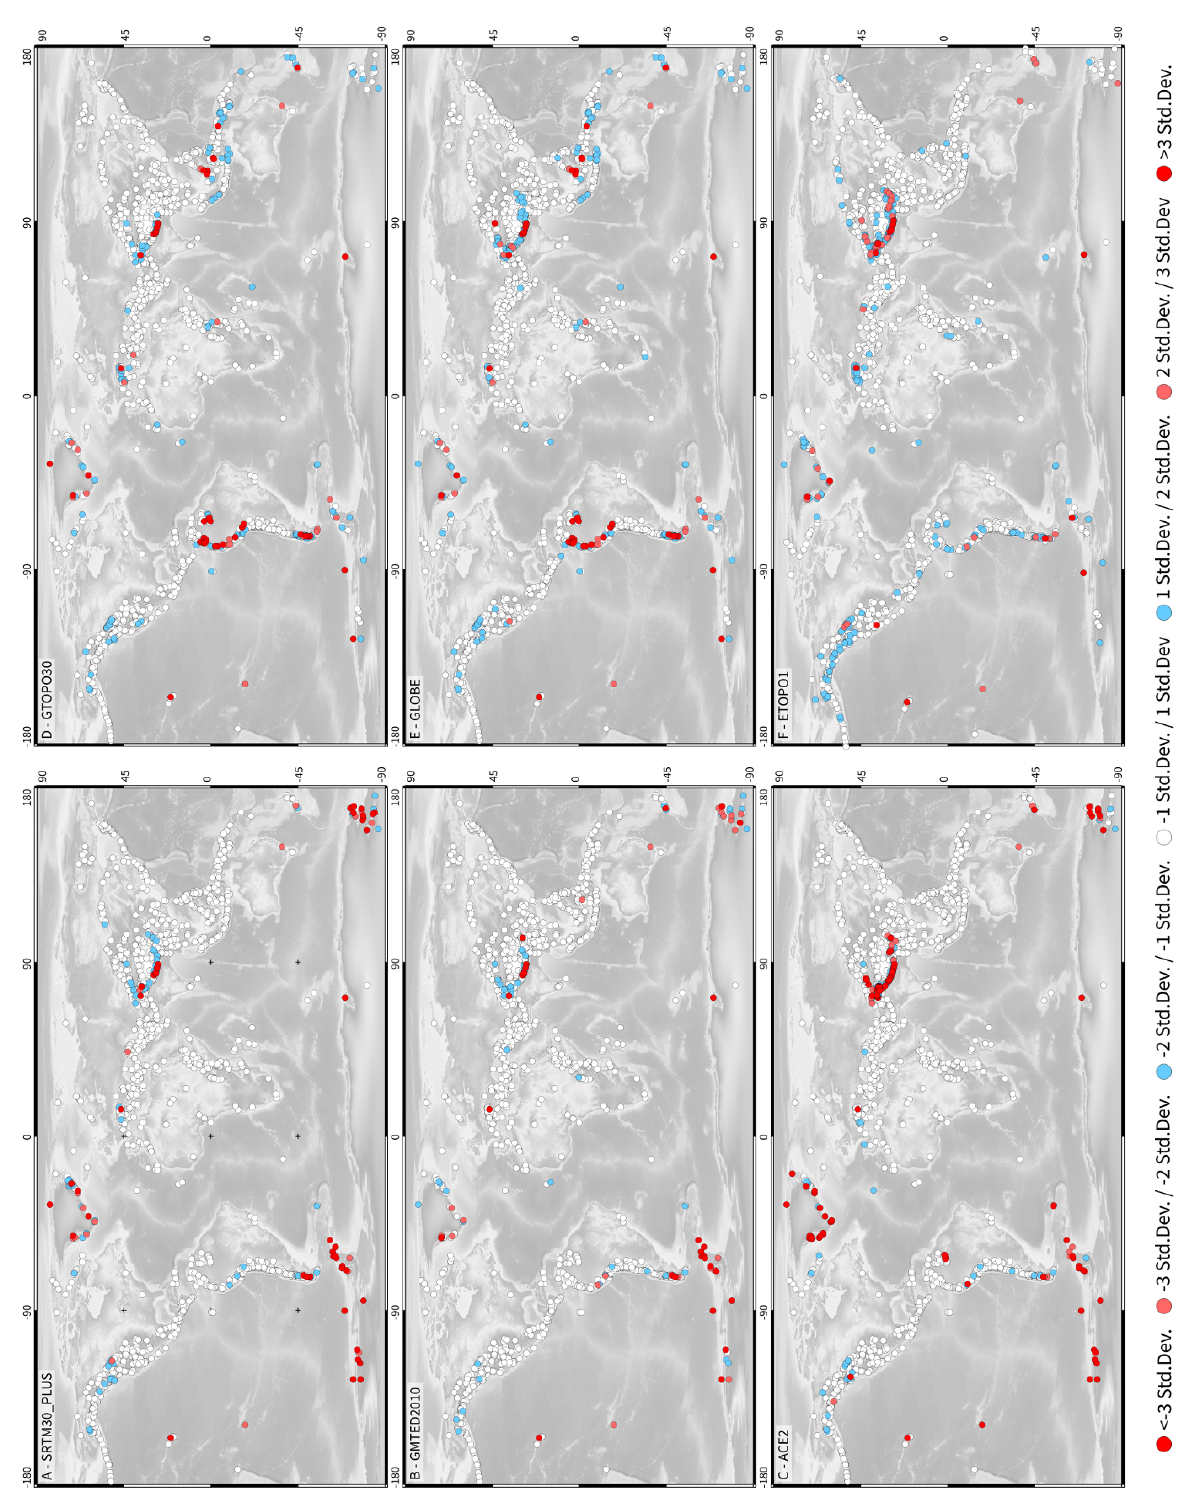
Figure 3: Map of ultra-prominent peaks, coloured according to the standard deviation of the differences between altitude of peak and analysed GDEM. A) SRTM30 PLUS; B) GMTED2010; C) ACE2; D) GTOPO30; E) GLOBE; F)